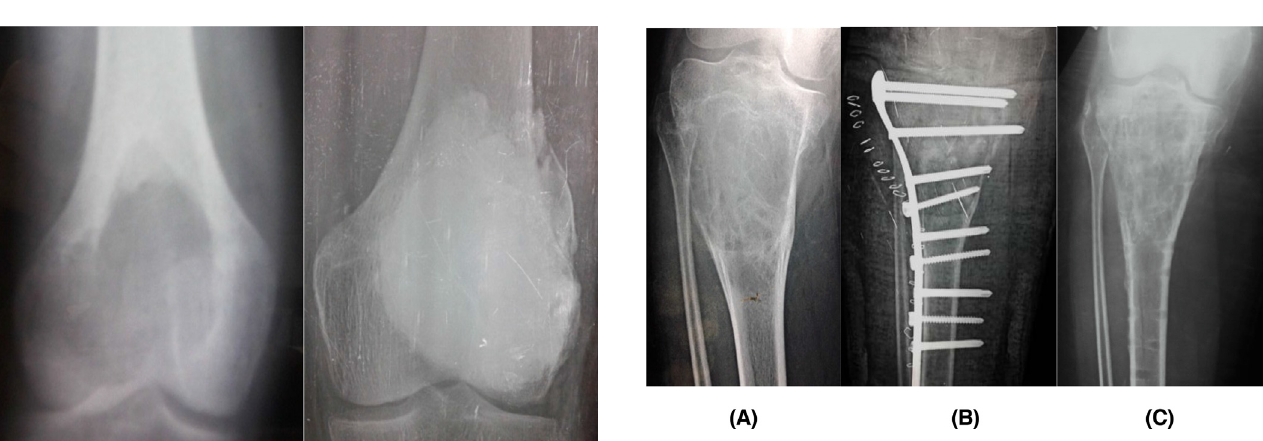
Figure 6. (A) Plain radiograph showed varus mal-alignment of recurrent ABC in the proximal tibia (case 16), (B) post-operative radiograph after revision surgery, and (c) last follow-up radio- graph 32 months post-operative showed complete